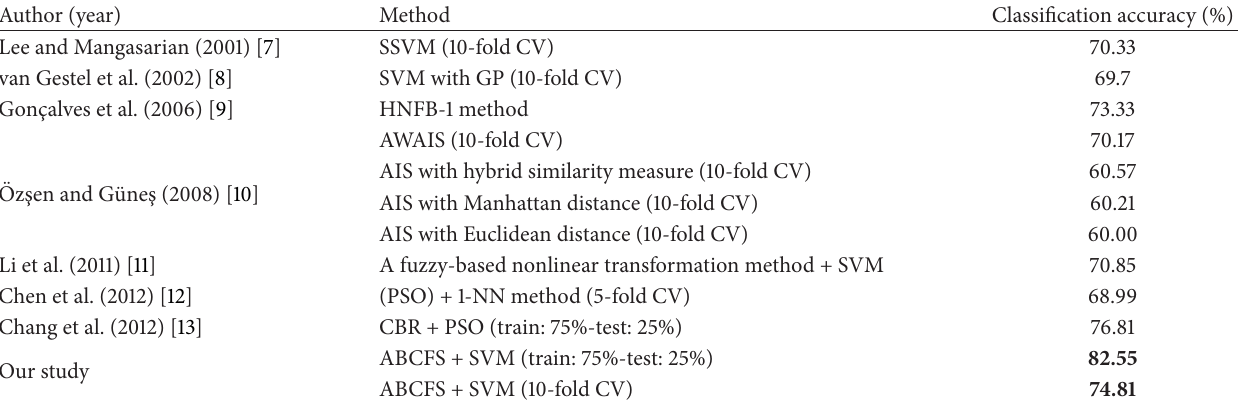
Table 9: Classification accuracies obtained by our method and other classifiers for the liver disorders